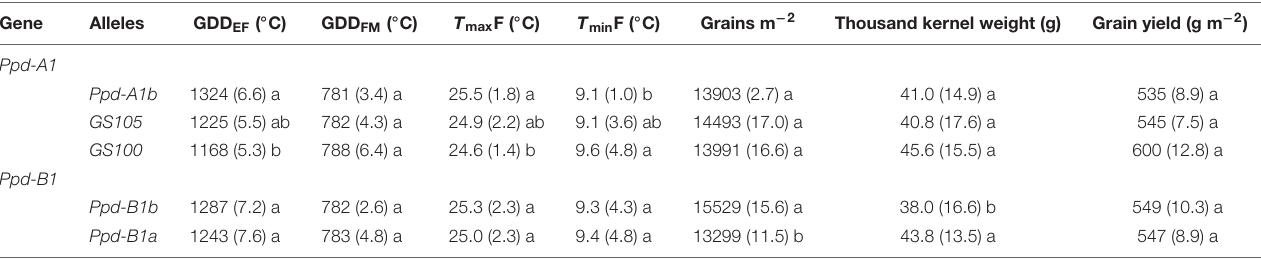
T max F: mean of the maximum temperatures of 5 days before and after flowering. T min F: mean of the minimum temperatures of 5 days before and after flowering. Different letters between alleles at each gene indicate differences according to LSD test at P < 0.05. The number of genotypes carrying each allele is shown in Table 2 .